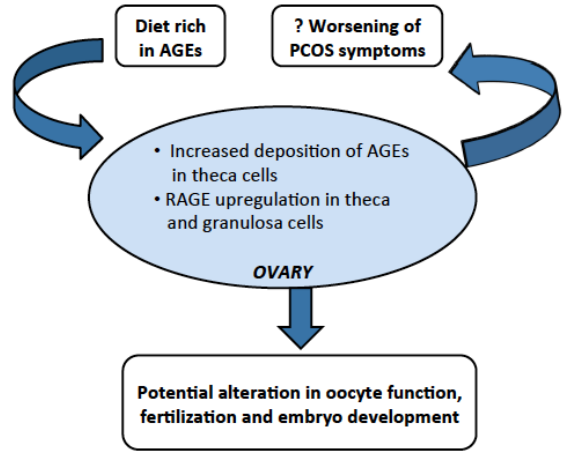
Figure 2. Possible involvement of AGEs in ovulatory dysfunction in PCOS.